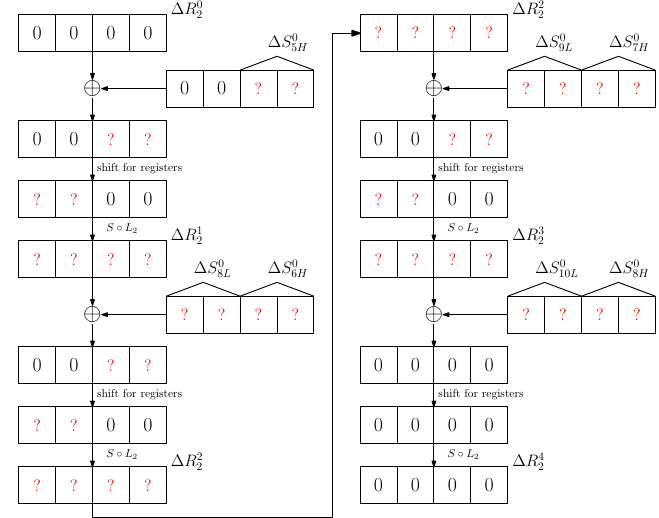
Figure 4: The difference transitions in FSM for the first 4